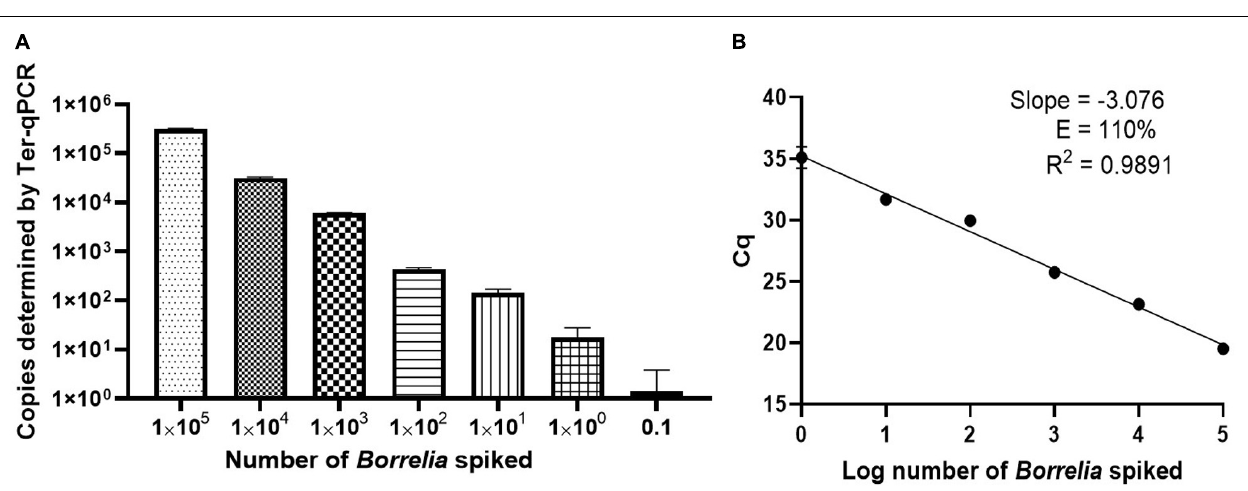
FIGURE 4 | Performance of the Ter-qPCR estimated by examining human blood spiked with tenfold serial dilutions of Borrelia cells (10 5 to 0.1). (A) : bar graph illustrating the number of spike-in Borrelia cells and the resulting copy numbers determined by the Ter-qPCR; (B) : Linear regression analysis between the known amount of spiked Borrelia cells and the resulting Cq values revealed a strong linear association. The slope, coefficient of correlation ( R 2 ) and efficiency of the reaction ( E ) are shown. Each dot represents the average value from triplicate repeats along with SD values obtained from two independent